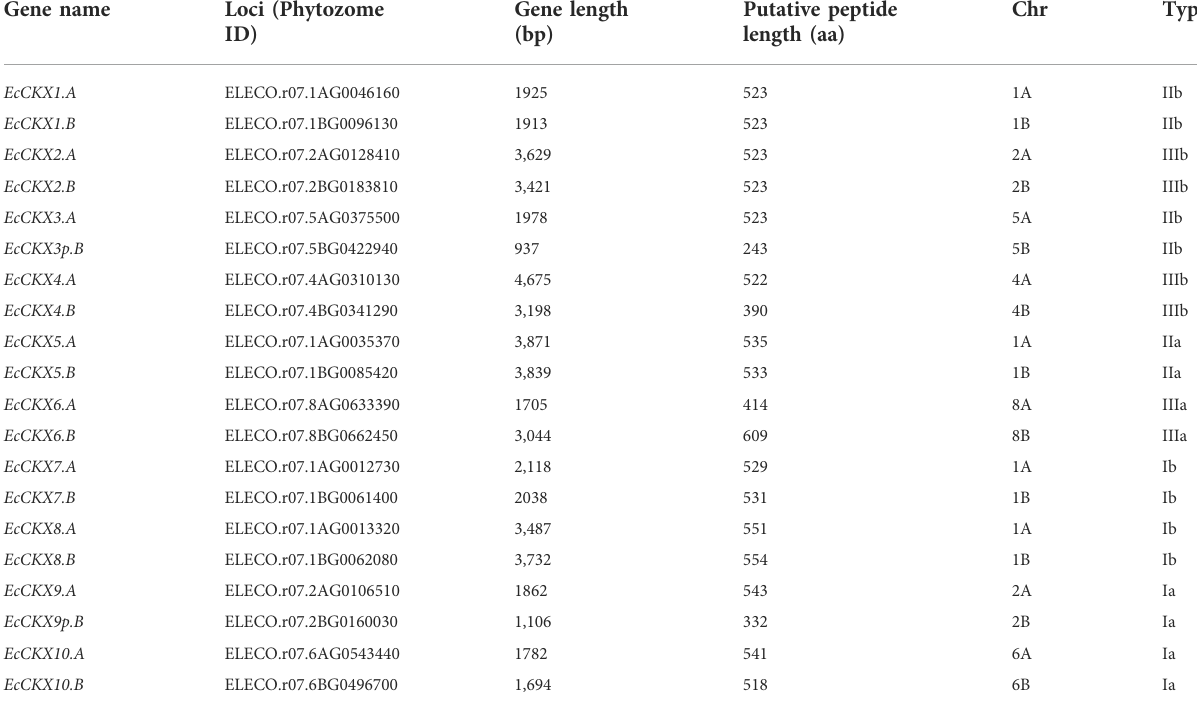
TABLE 1 List of the identi fi ed EcCKX genes in the genome of fi nger